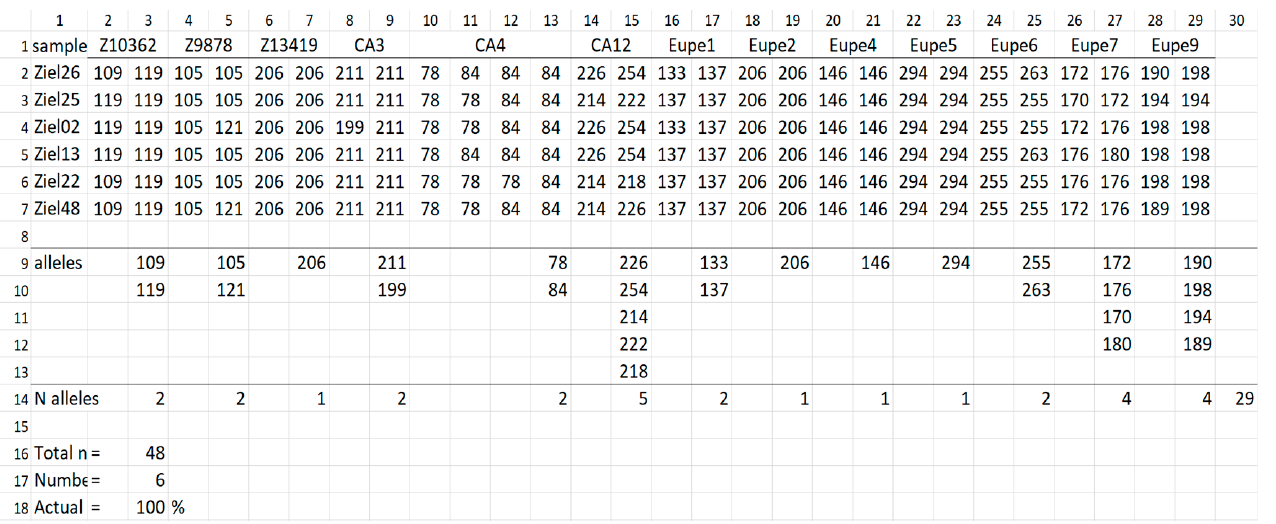
Figure 3. Set of 5 samples that enable transfer to the next generation all alleles detected across genetic profiles of fish from Zielonka population. Line 1, locus name; line 2–7, ID of samples chosen by the software are given in column 1, and their genetic profiles in columns 2–29; line 9–13, headings of lines (column 1, lines 9–18), list of alleles transferred by this set and number of alleles at a given locus and across all loci (line 14 and column 3–30); line 16, total number of samples in input file; line 17, number of samples selected from the input file; line 18, actual percentage of genetic variation detected in the input file that can be transferred to the progeny by using set of samples indicated by software. The Genassemblage 2.2 identified 21, 27, 29, 53 alleles across all loci (nA) in the samples from Mikołajki Pomorskie (MP), Drozdowo (DR), Zielonka (ZI) and Bełcz ˛ac (BE), respectively (Table 1). In the file containing all samples, 66 alleles were identified. The number of alleles per investigated individual (nA/N) ranged from 0.44 to 1.10 among populations. The lowest value of this indicator was in the group of all